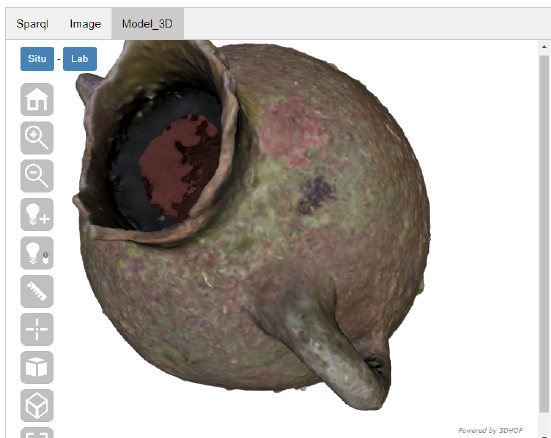
Figure 8: A 3D view display tab (powered by 3DHop) of artifacts in the Xlendi 2D Web tool corresponding to the Amphorae A02 as the selection in the Figure 4.